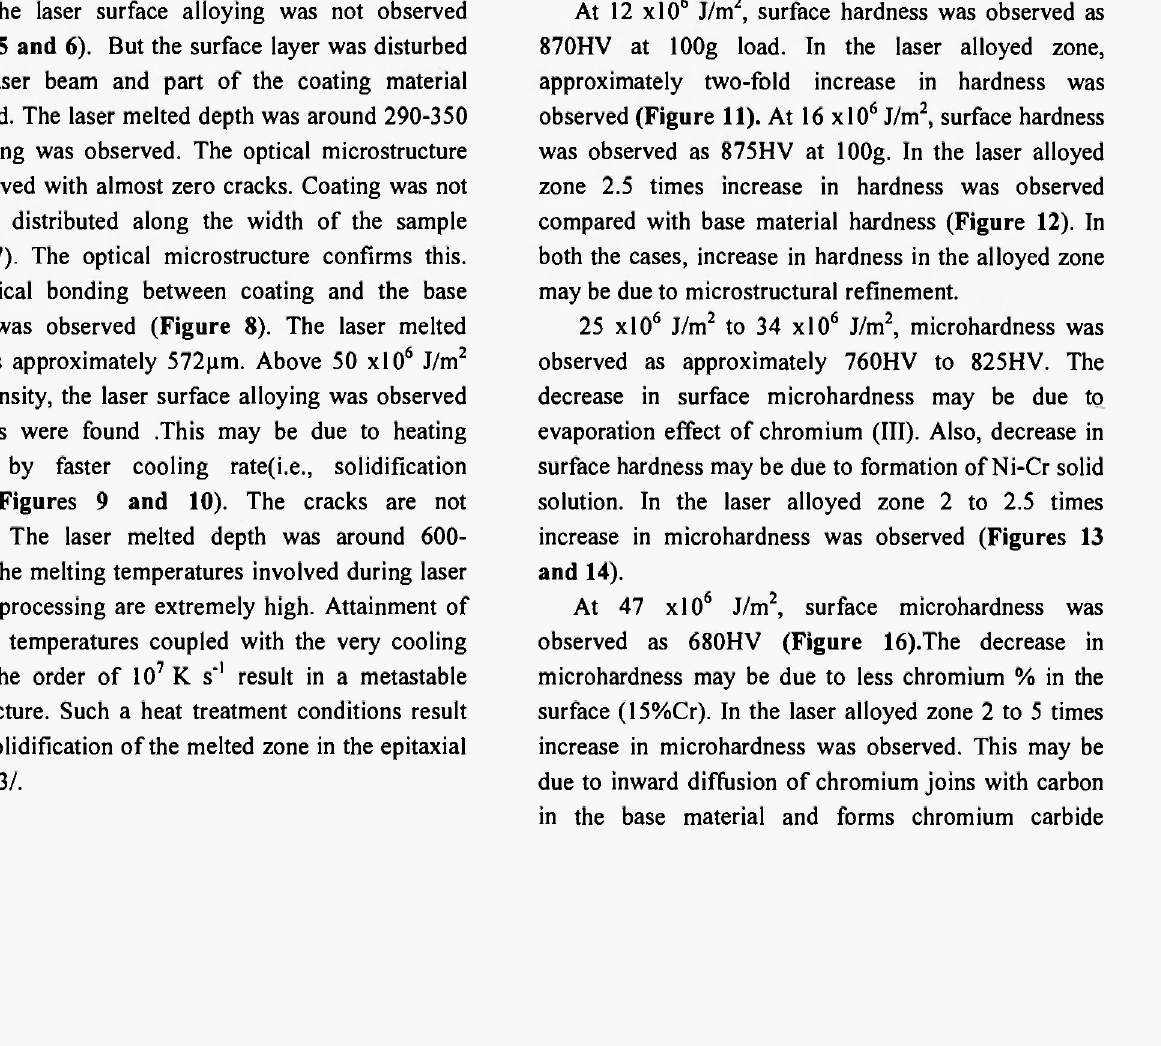
16).The decrease in microhardness may be due to less chromium % in the surface (15%Cr). In the laser alloyed zone 2 to 5